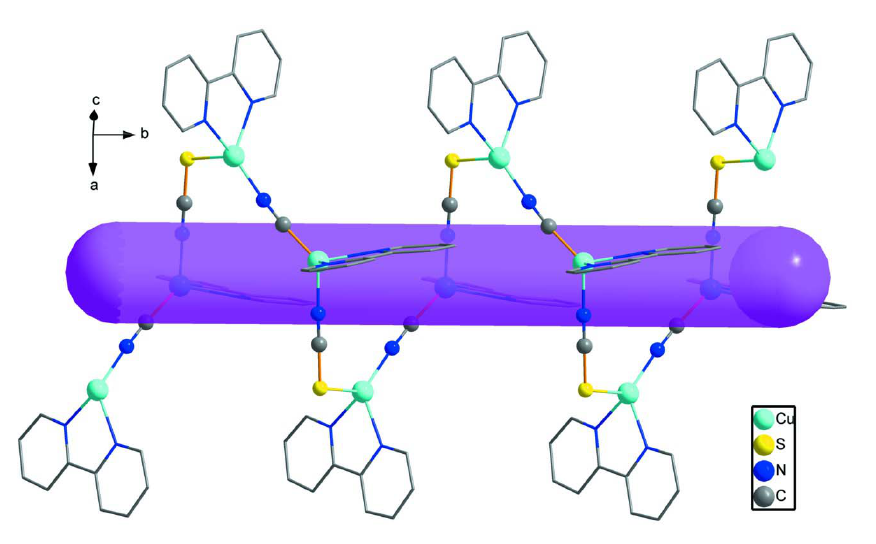
Figure 2 One-dimensional helical chain in the title compound. catena -Poly[[(2,2 ′ -bipyridine- κ 2 N , N ′ )copper(I)]- µ - cyanido- κ 2 C : N -[(2,2 ′ -bipyridine- κ 2 N , N ′ )copper(I)]- µ - thiocyanato- κ 2 S : N ] Crystal